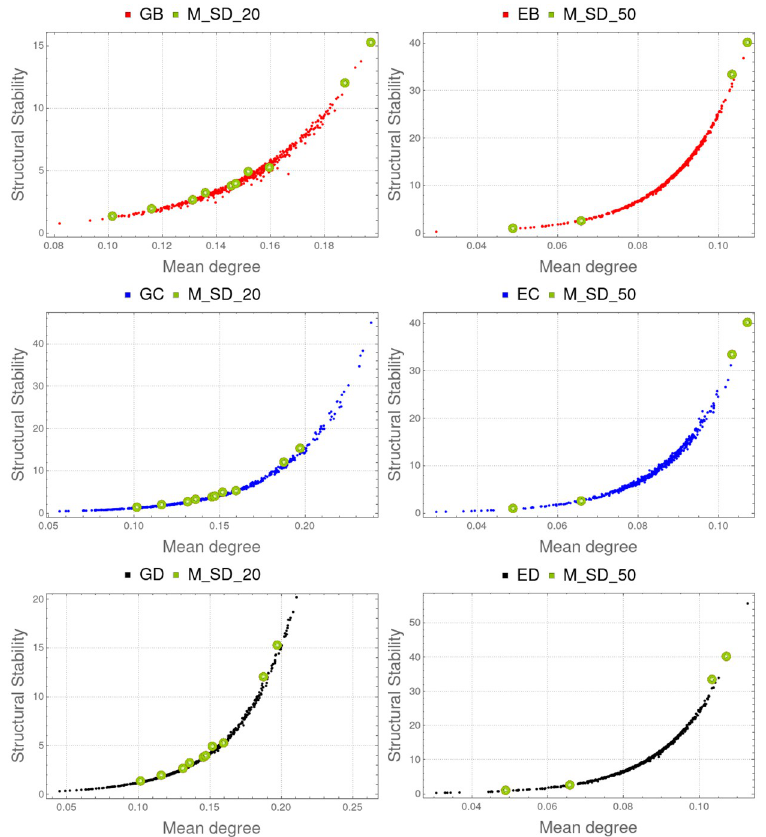
Fig 9. Degree centrality and structural stability. Left (top to bottom): Comparison of M_SD_20 with GB , GC and GD . Right (top to bottom): Comparison of M_SD_50 with EB , EC and ED . Spearman correlation coefficient is greater than 0.994 in all these cases (Table 2). In these graphs, degree centrality grows with the sum of the cooperation ( γ competition ( β ij )